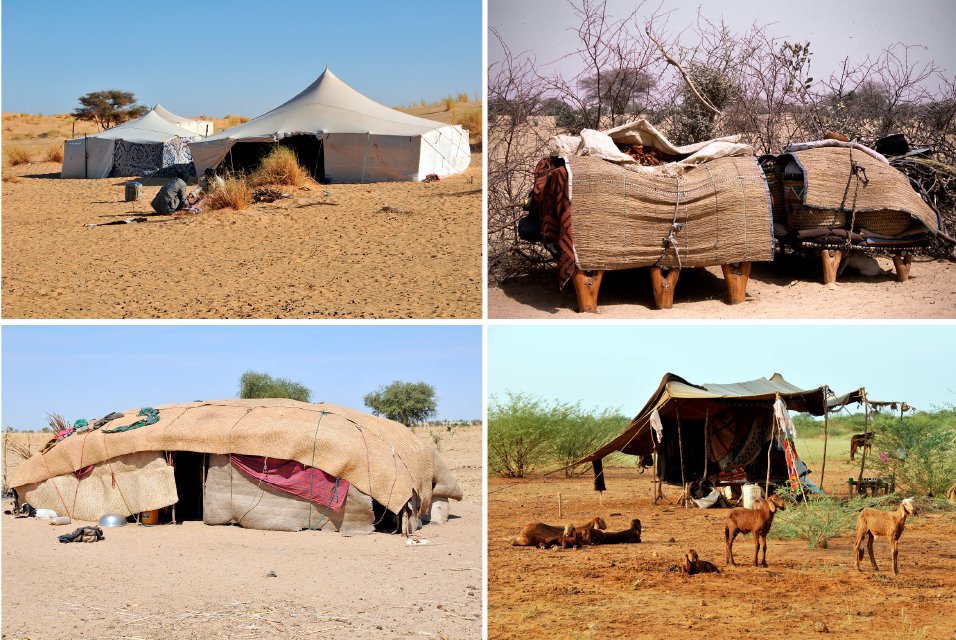
Figure 1. Examples of the camps and architecture of nomadic pastoralists in the Sahel belt. Top left: white fabric tents of the Moors in Mauritania; top right: tables for storing dishes at campsites of the Fulani Wo ɗ aa ɓ e in Niger; bottom left: a tent made of mats in the camps of Baggara Arabs in Chad; and bottom right: lightweight and easily potable tents of the nomadic Shanablah Arabs in Kordofan, Sudan (Copyright: Viktor Č erný, 2022).